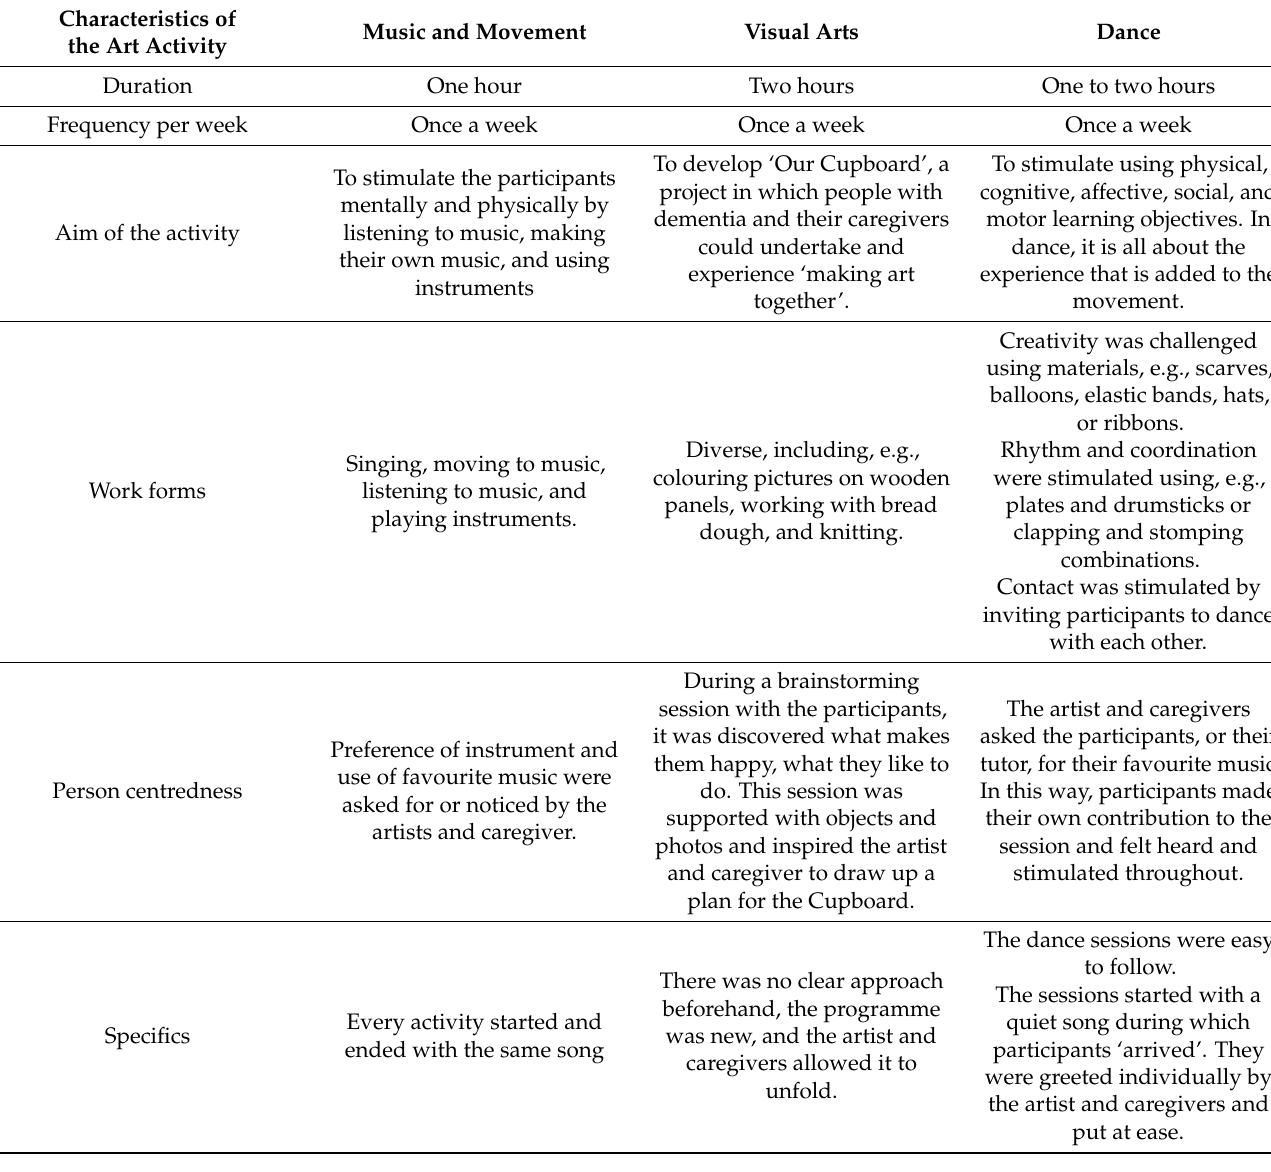
Table 1. Characteristics of the three art